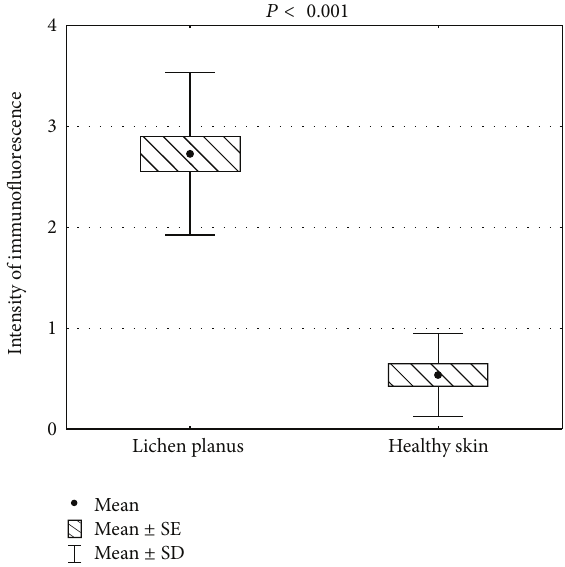
Figure 2: Comparison of the mean immunofluorescence intensity of anti-IL-31 staining between lichen planus and healthy skin (SE: standard error, SD: standard